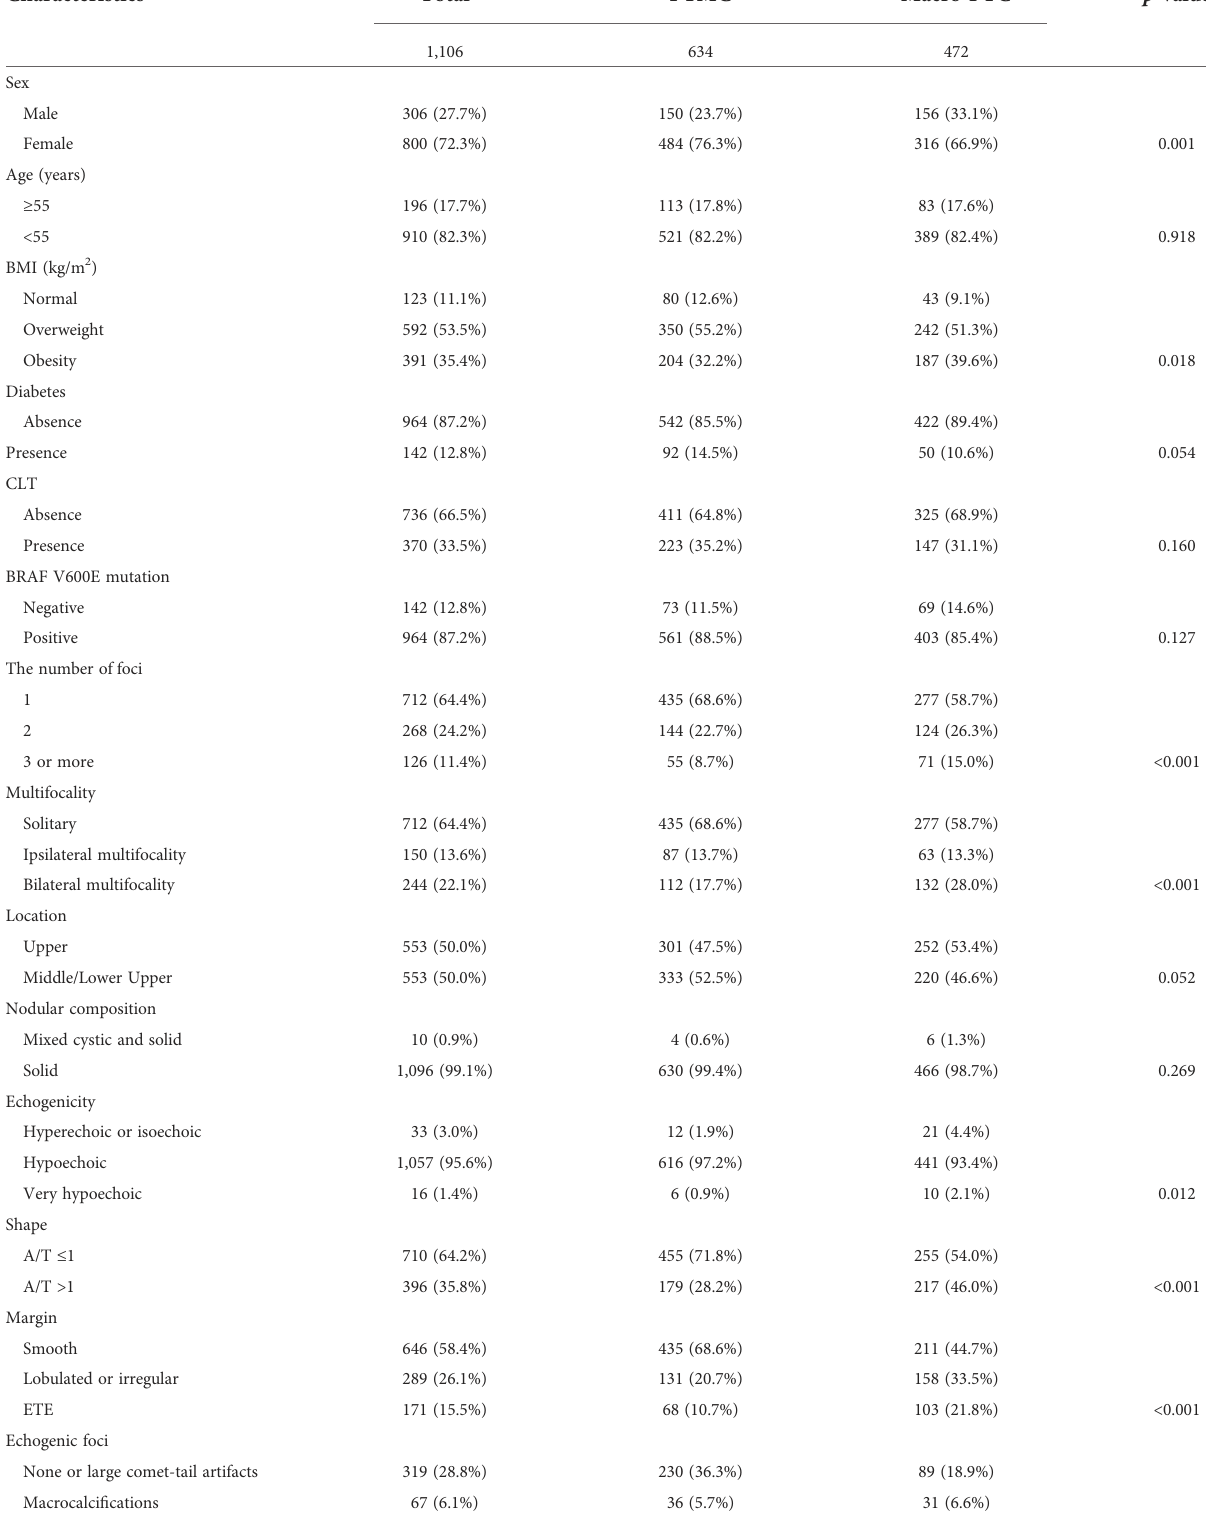
TABLE 1 Clinicopathological features of PTC patients with different tumor